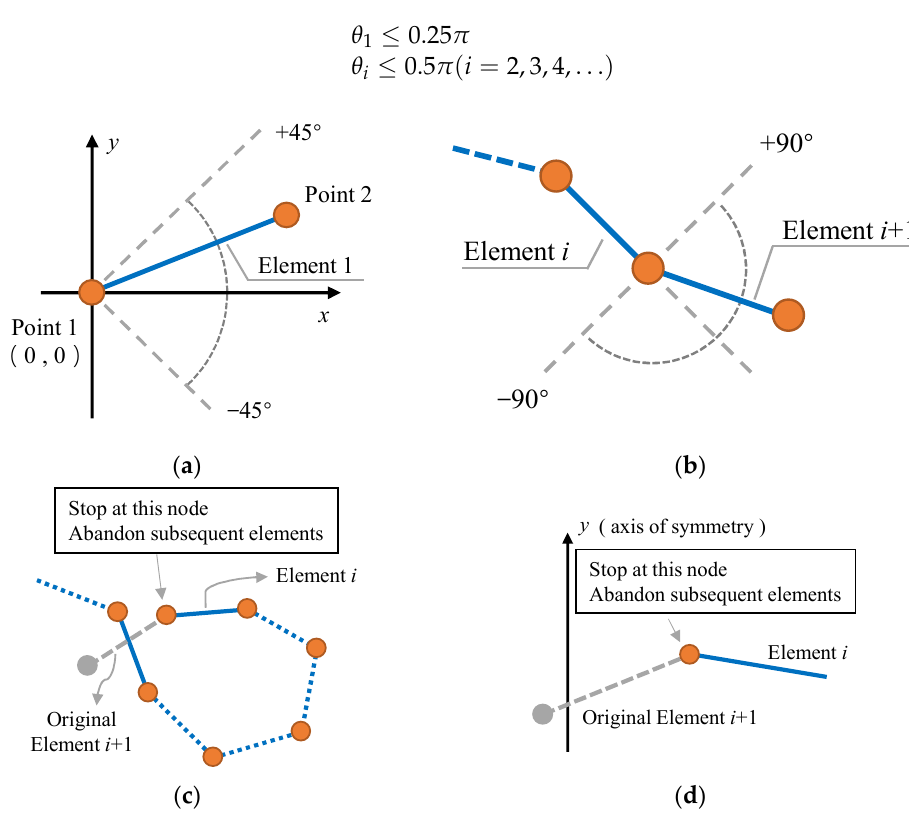
Figure 12. Constraints on the free-form shape of cross-section. ( a ) The included angle between element1 and the folded element is not less than 90 ◦ ; ( b ) The included angle of adjacent elements shall not be less than 90 ◦ according to the restrictions; ( c ) The member element itself does not cross and tie; ( d ) The self-inter cross-section of the complete cross-section will also